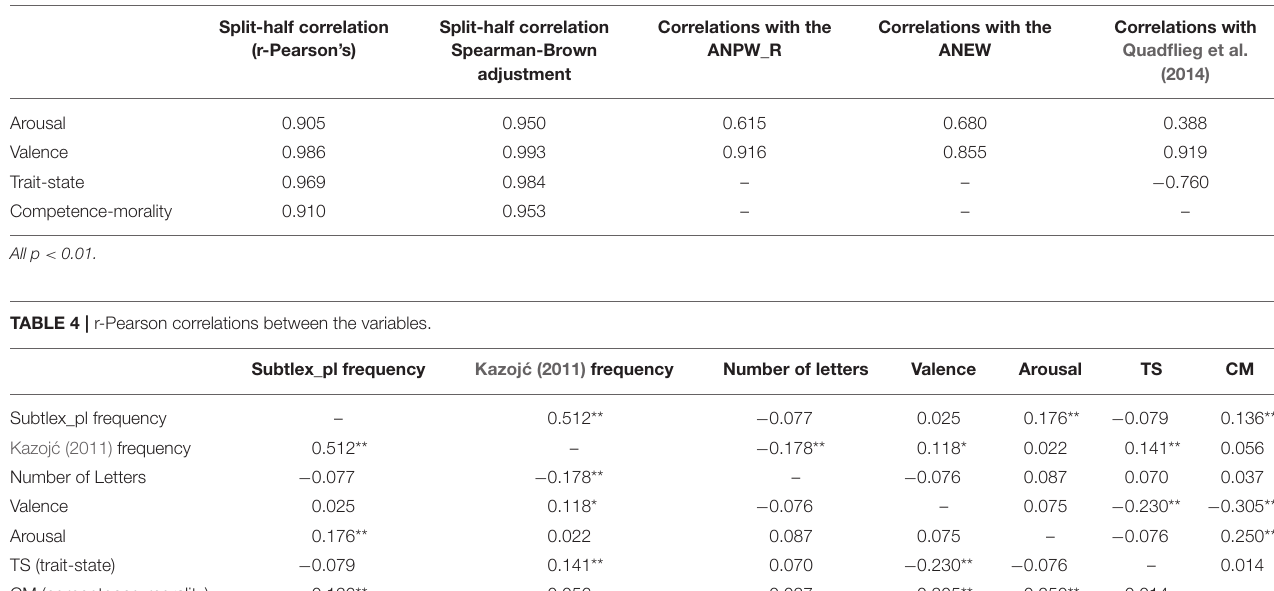
TABLE 3 | Reliability and stability estimations for every dimension.